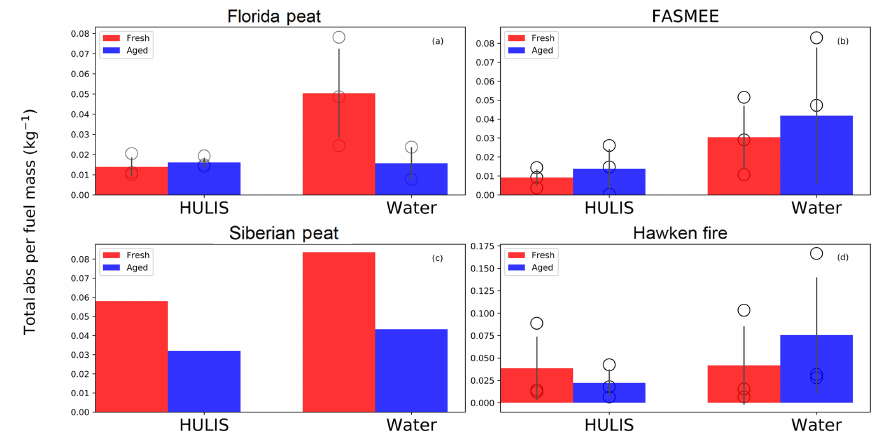
Figure 6. Comparison of total absorbance per fuel mass consumed for fresh and aged aerosols in water and HULIS extracts, normalized to 1mL extraction volumes. Bars, circles, and error bars represent the mean values, individual observations, and standard deviations, respec- tively. No error bars are given for Siberian peat, because only one experiment was performed with this